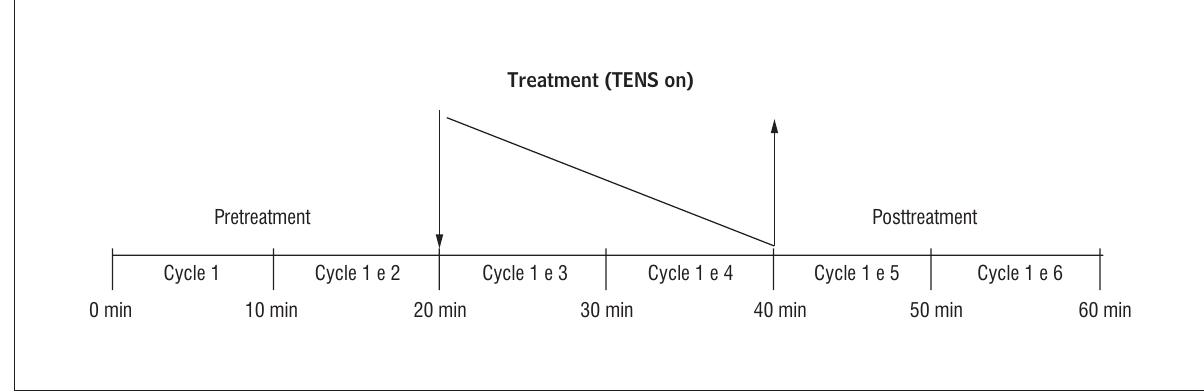
Source: Johnson and Tabasam (28).